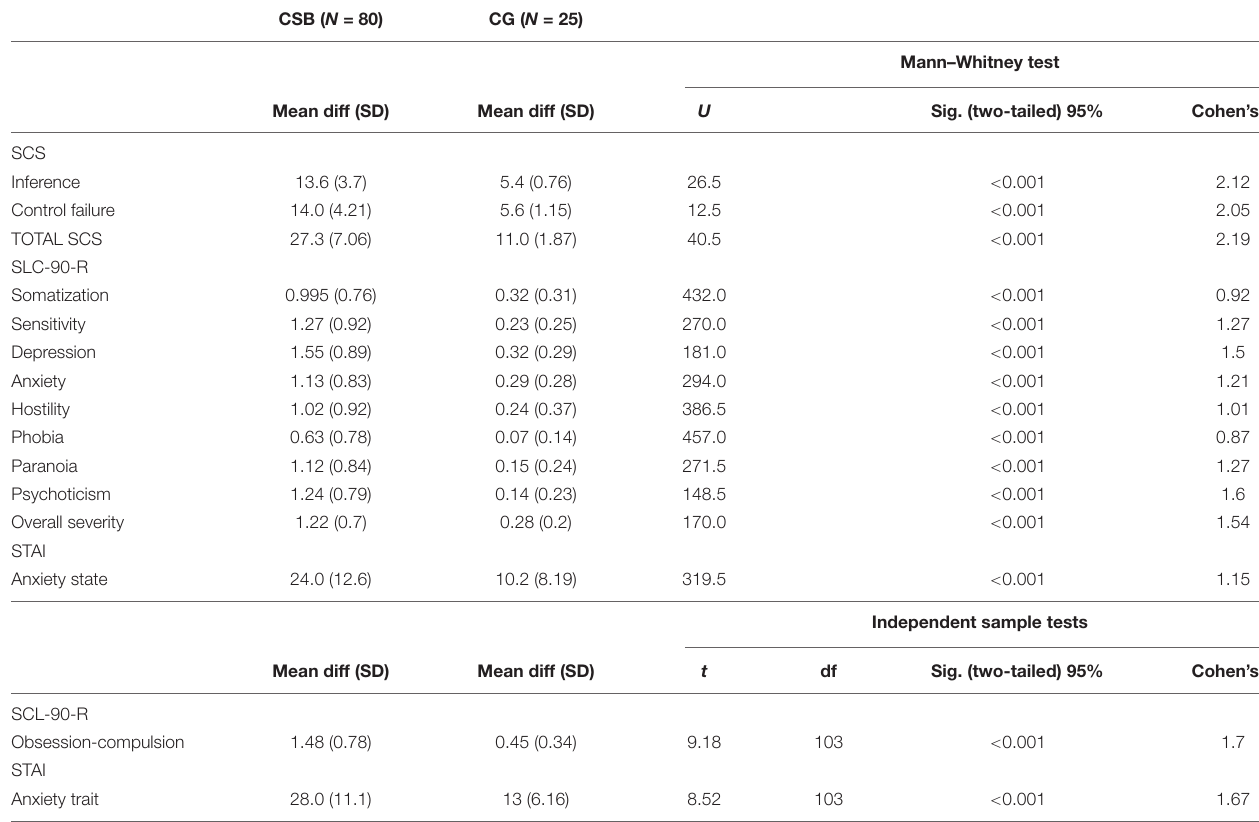
TABLE 2 | Comparison between experimental and healthy control groups of psychopathological